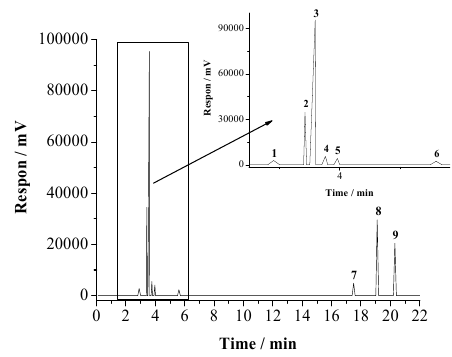
Figure 2. Chromatogram of honeycomb waste extract.